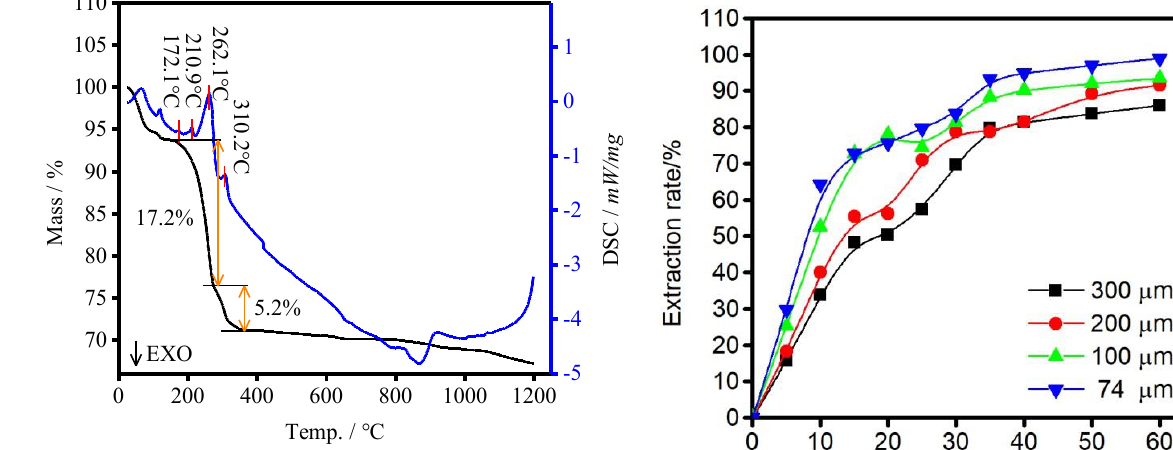
Figure 5. TG-DSC analysis of the NH 4 Cl and EBFS mixture Figure 5: TG-DSC analysis of the NH